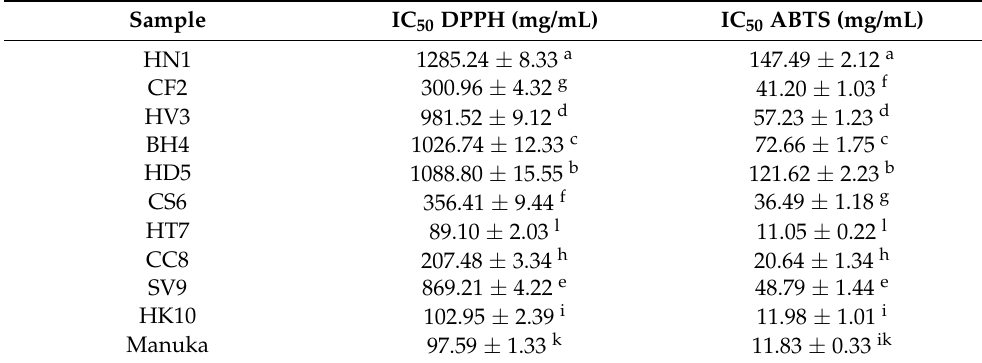
Table 8. The antioxidant capacity of different types of honey.